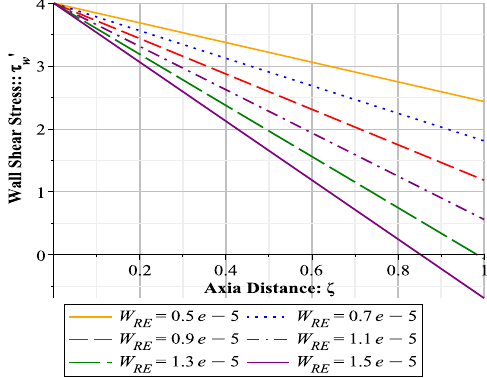
Figure 5. Behavior of τ w ’ with ζ for different values of W RE